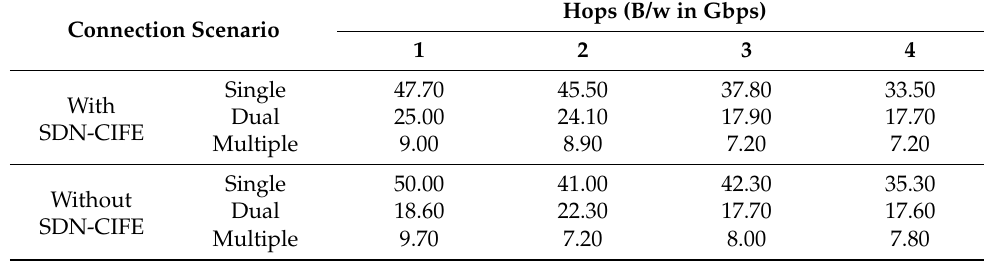
Table 4. Bandwidth Delivery Test.